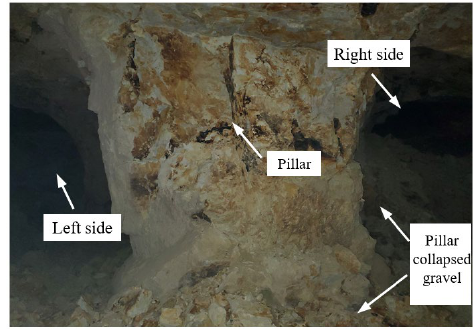
Figure 14. Partial collapse of pillar.